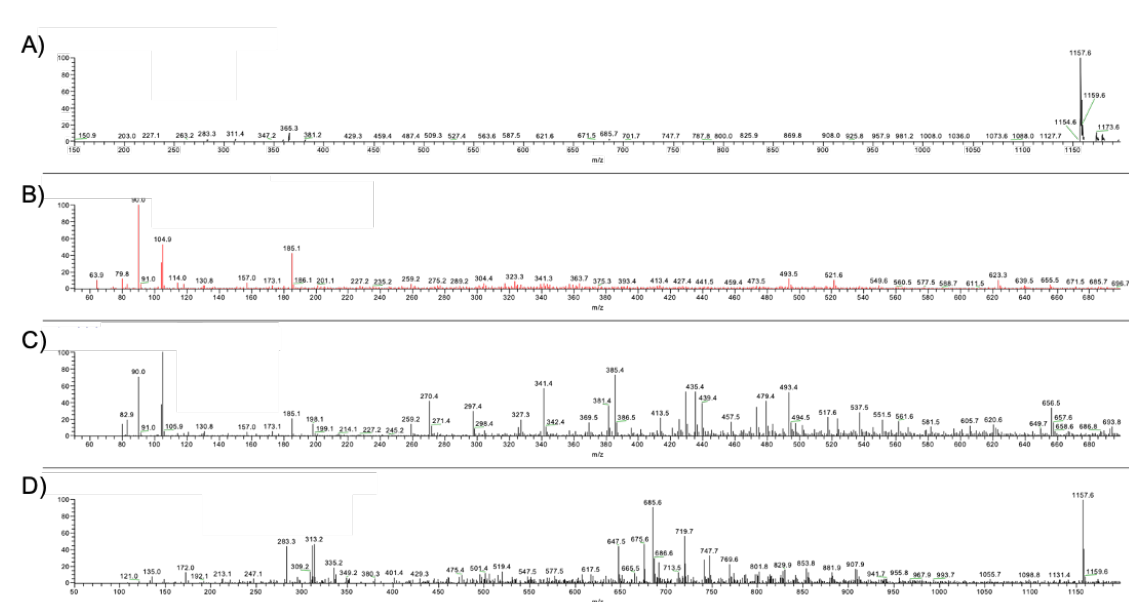
Figure 2. ESI-MS spectra of ( A ) b-CD, ( B ) S. montana EO, ( C ) solid-state b-CD–EO-S in the high mass range and ( D ) solid-state b-CD–EO-S in the low mass range.